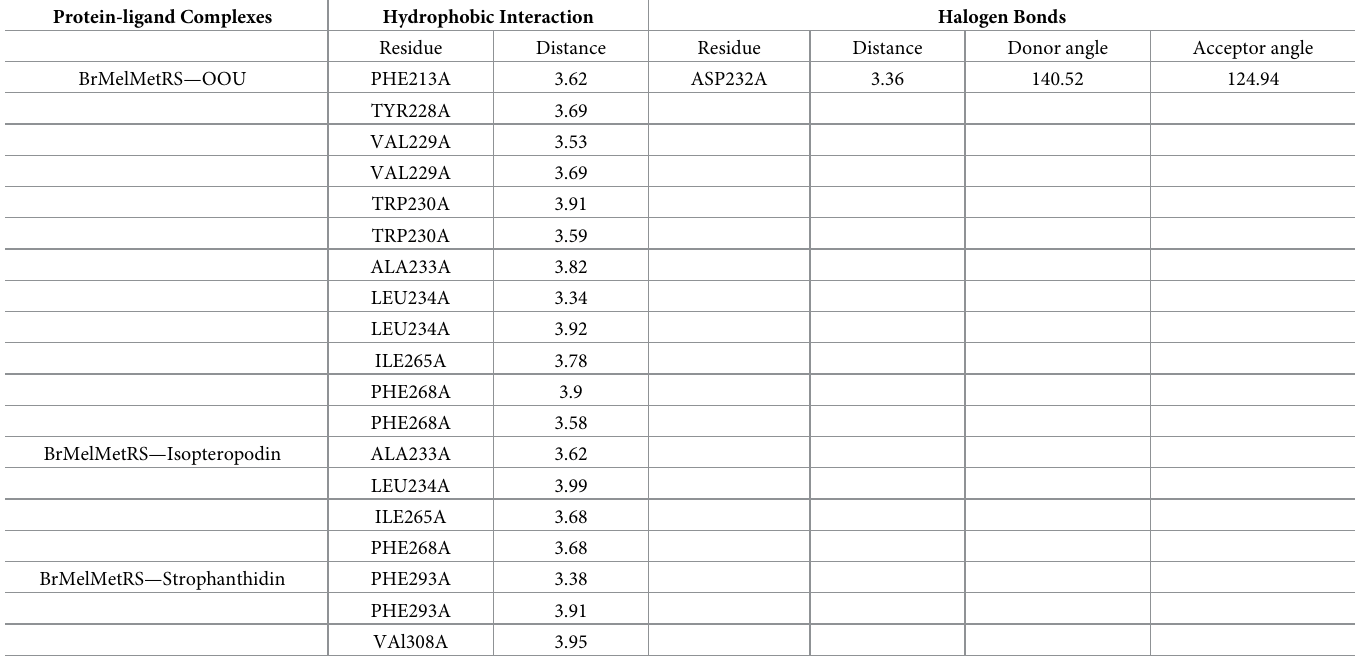
CBX51367.1 had a query cover of 91% while the other two showed short alignments each with 22% query cover. Table 5. Hydrophobic interactions and Halogen